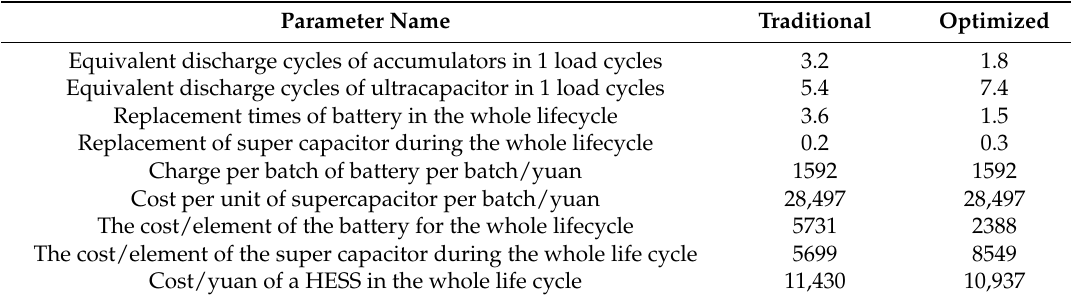
Table 2. Economic benefit analysis of traditional hybrid energy storage capacity of the